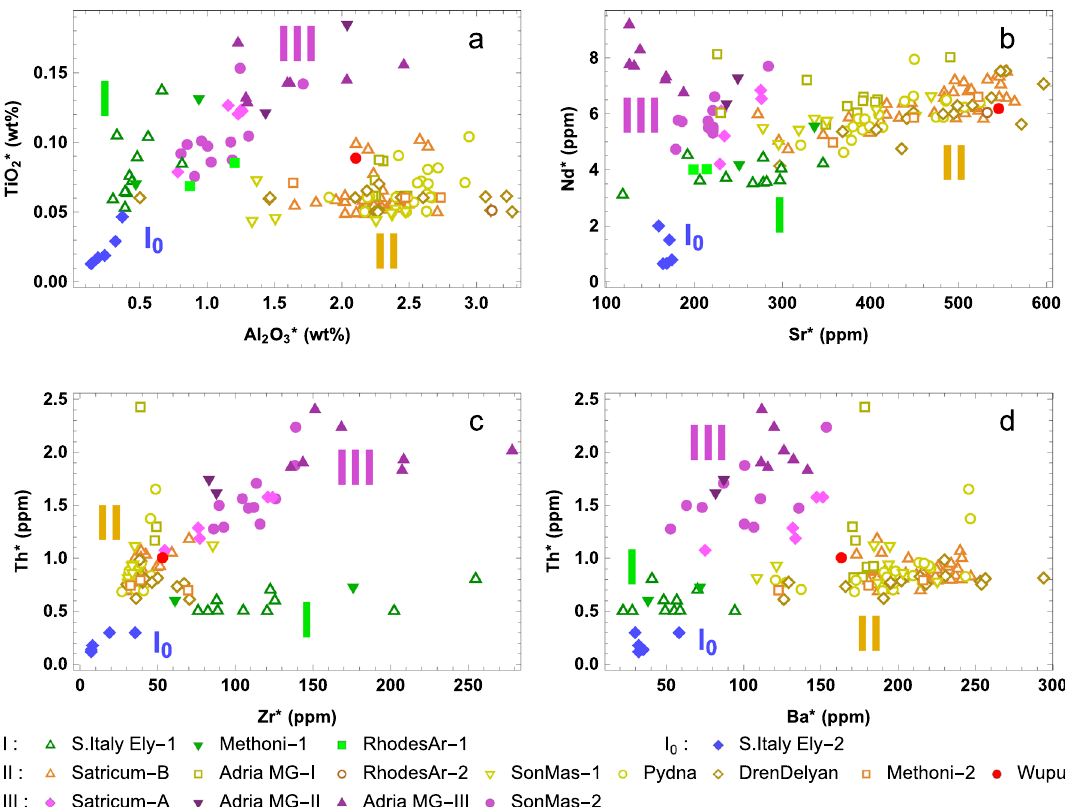
Figure 1. Chemical composition shows three major types (I, II, and III) and one minor type (I 0 ) for natron glass dated to the 8–2 C. BCE. ( a ) TiO 2 vs Al 2 O 3 . ( b ) Nd vs Sr. ( c ) Th vs Zr. ( d ) Th vs Ba. The samples are from: southern Italy’s early ‘classic’ natron glass (subgroup 1: 8–6 C.; subgroup 2: 8–7 C.) 25,26 ; Rhodes, Greece, of the Archaic period (640–600, two subgroups) 31 ; MG-II samples from Satricum, central-west Italy (4–3 C., clusters A and B) 30 ; Adria, northern Italy (Mediterranean Group-I, -II, -III: 5 C., 3 C., 2 C., respectively) 29 ; Pydna, Greece (6–4 C.) 32 ; Methoni, Greece (6–4 C., two subgroups) 32 ; Son Mas, Mallorca, Spain (subgroup 1: possibly 4–3 C.; subgroup 2: possibly 3 C.) 35 ; Dren-Delyan, Bulgaria (end of 6—upper 4 C.) 36 ; and Wupu, China (760–481, discussed in the next section). All dates are in BCE. All element data are normalized (marked with asterisks). Not every element is available for all